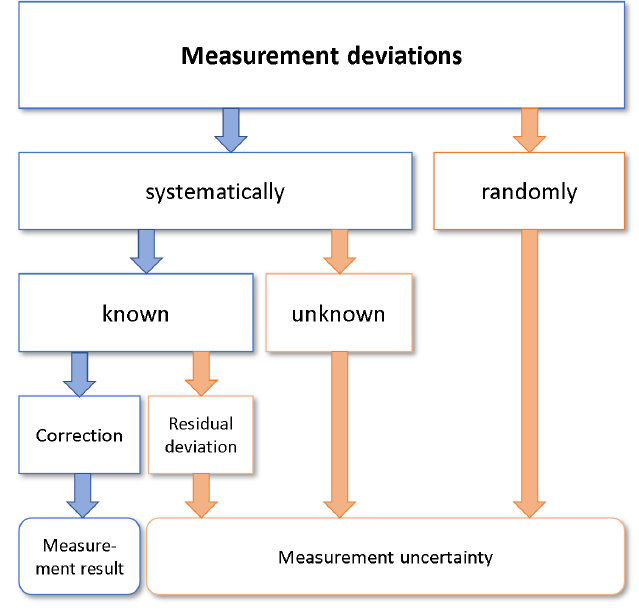
Figure 2. Overview of measurement deviations